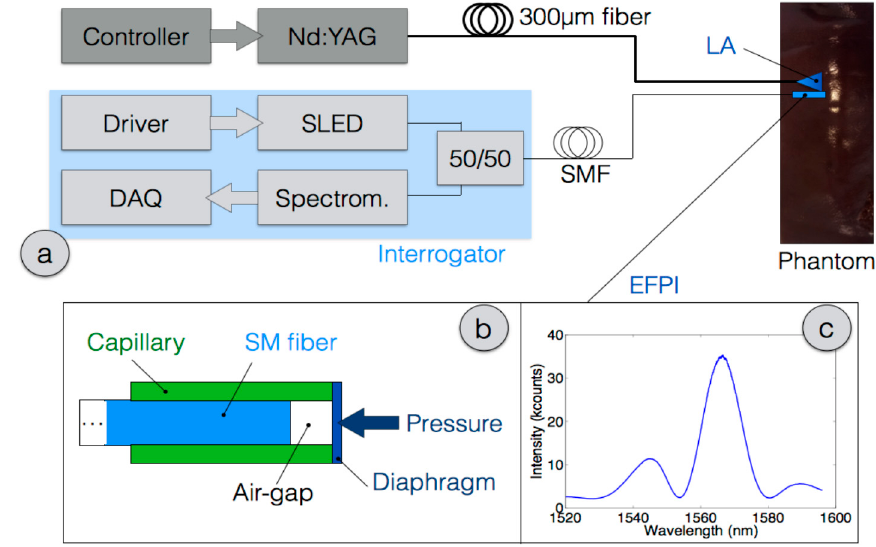
Figure 1. Schematic of the LA on animal phantom, and EFPI pressure detection: ( a ) Schematic of the system; ( b ) Sketch of the EFPI all-glass probe; ( c ) Spectrum of the EFPI probe.